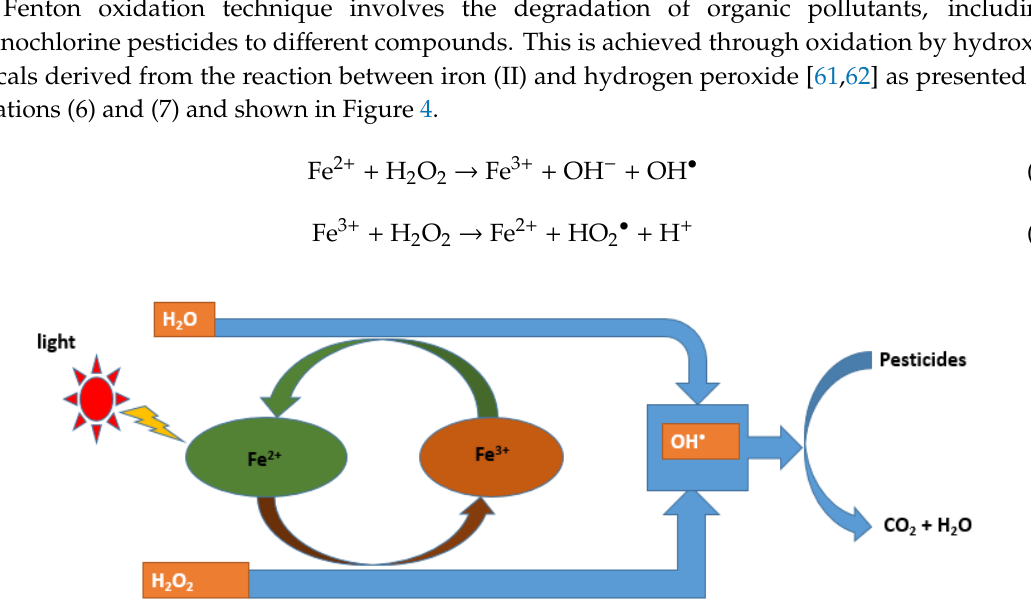
Figure 4. Photo–Fenton degradation of organochlorine pesticides. Adapted with permission from [63]. Copyright (2012) American Chemical Society.